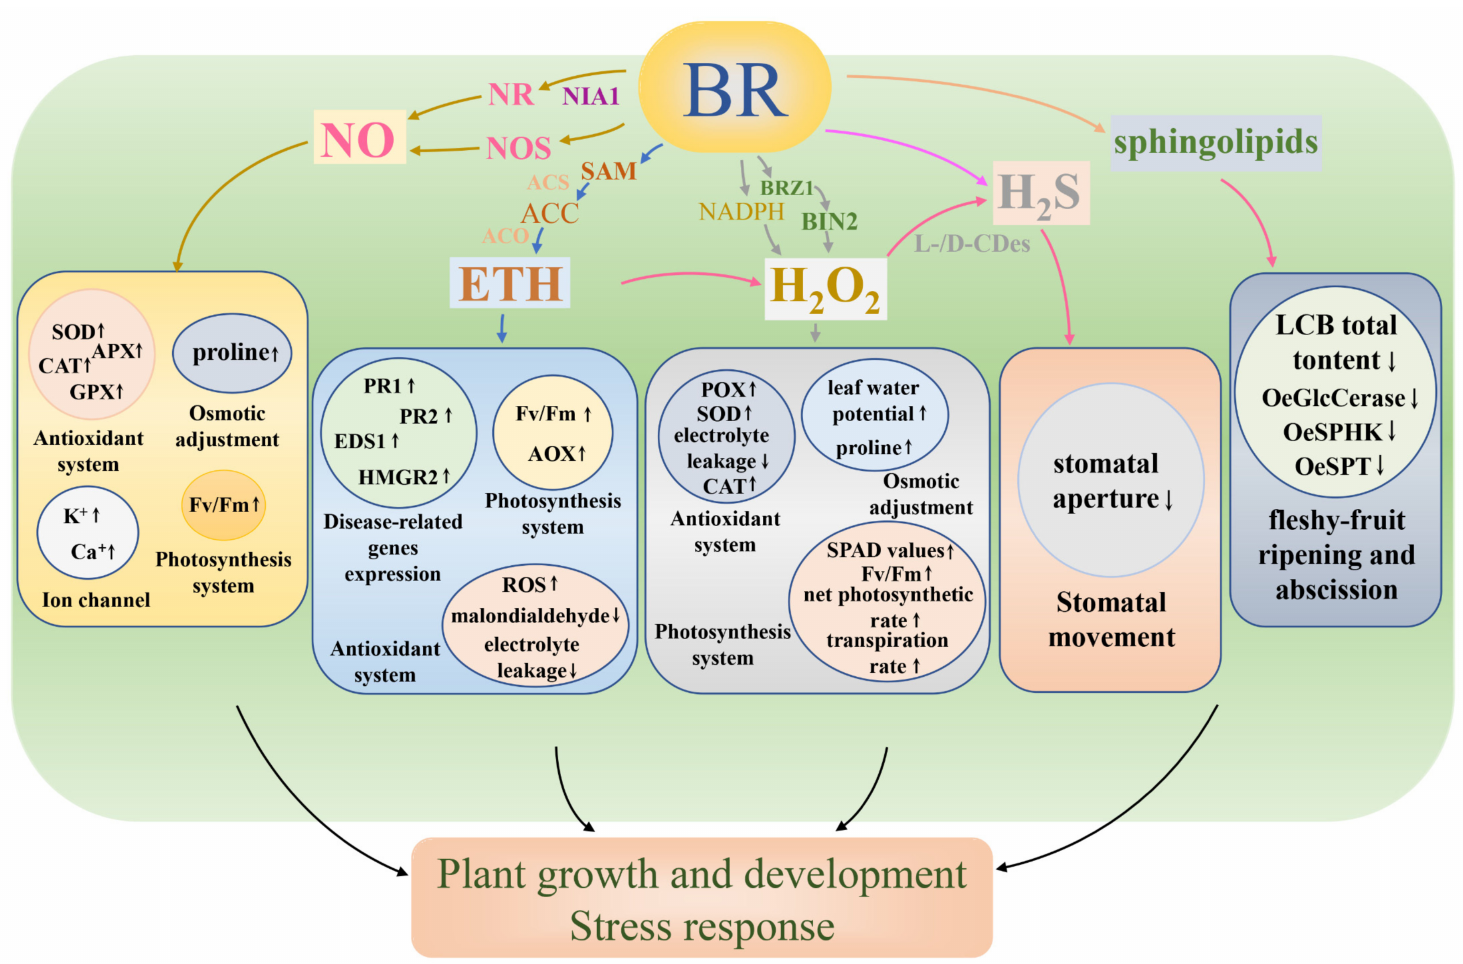
Figure 2. Model of the signal pathways by which brassinosteroids (BRs) crosstalk with other SMCs in the growth, development, and stress response of plants. In terms of interaction with nitric oxide (NO), BRs induce NO generation through nitrate reductase (NR) and NO synthase (NOS) pathways. As the main synthesis pathway, NITRATE REDUCTASE1 (NIA1) is responsible for BR-induced NO through the NR pathway. The crosstalk between BRs and NO regulates the antioxidant system, the photosynthesis system, osmotic adjustment, and the ion channel. Additionally, BRs are involved in the biosynthesis of ethylene through S-adenosyl-L-methionine (SAM) and 1-aminocyclopropane-1-carboxylic acid (ACC) and enhance